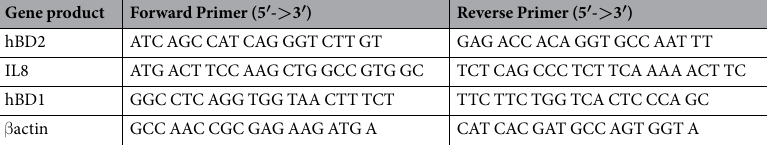
Table 1. Primers used in quantitative real-time